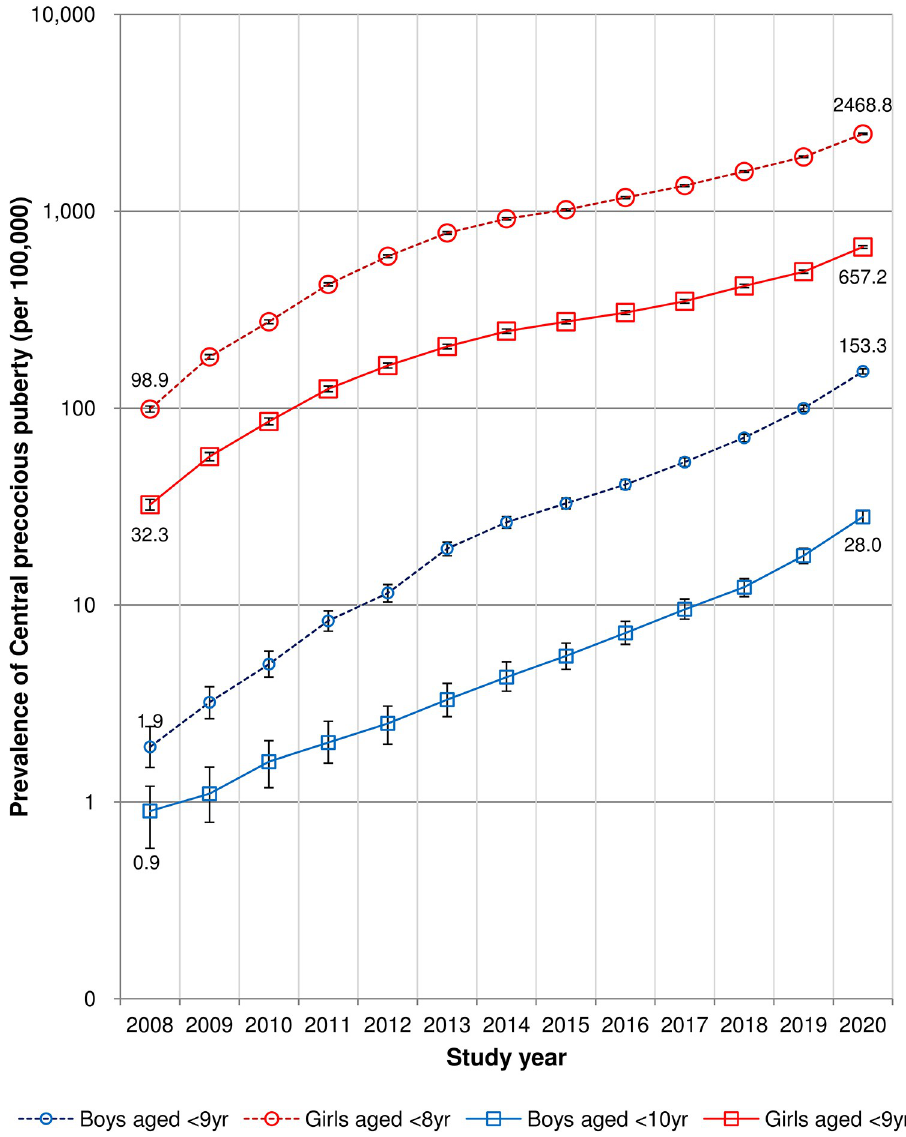
Fig 4. The annual prevalence of central precocious puberty according to sex, calendar year, and two diagnostic age limits. The error bars show the 95 percent confidence intervals for the prevalence estimates.